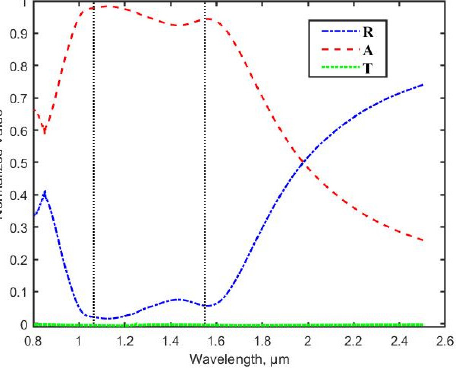
Figure 2. Calculated absorbance (A), reflectivity (R), and transmittance (T) of the metagrating. The two vertical dashed lines mark the 1.064 μ m and 1.55 μ m wavelengths,